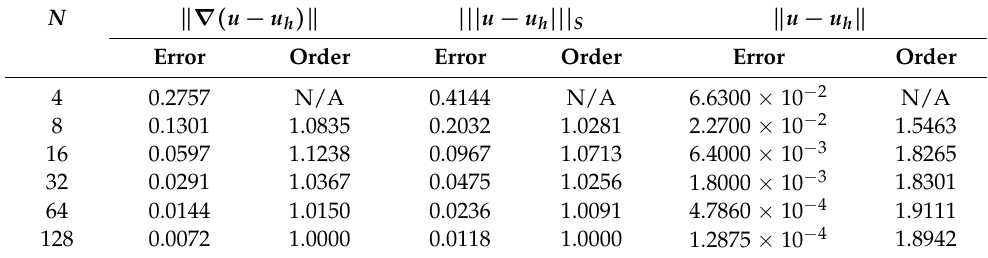
Table 1. Experiment results for the exact solution u = x 2 + y 2 with B.C.